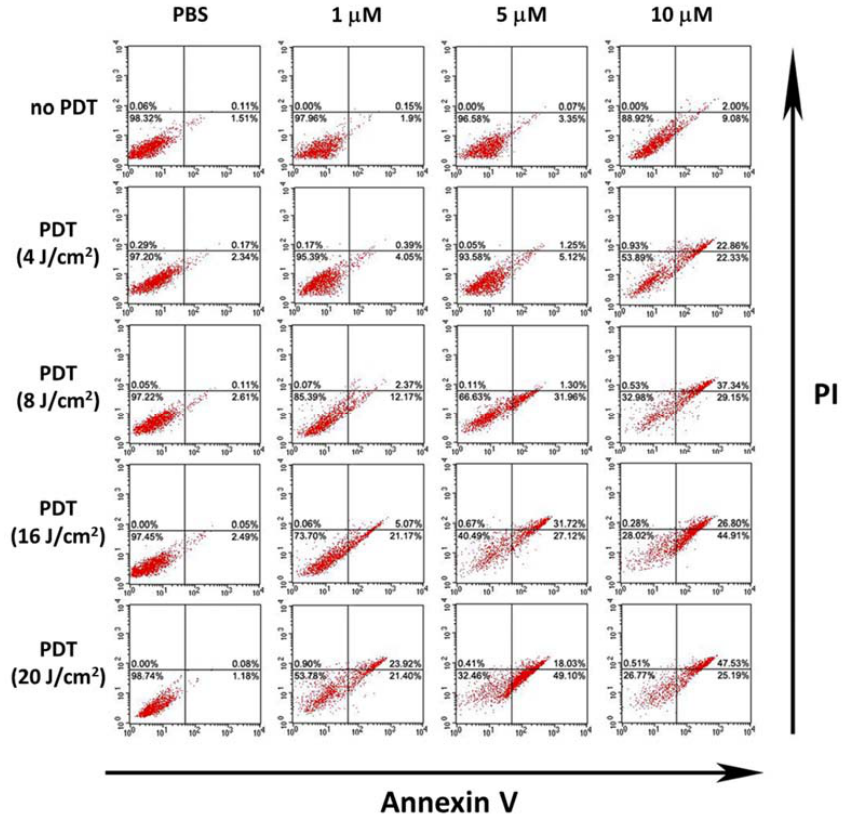
Figure 6. FACS analysis of A549 cells after treating with PBS or various concentrations (1, 5, and 10 µ M) of NMPi followed by light irradiation at 0, 4, 8, 16, or 20 J/cm 2 . The cells were categorized as follows: both annexin V ‐ FITC and PI negative cells, undamaged; annexin V ‐ FITC positive and PI negative cells, early apoptotic; both annexin V ‐ FITC and PI positive cells, late apoptotic; and annexin V ‐ FITC negative and PI positive cells, either late apoptotic or necrotic.